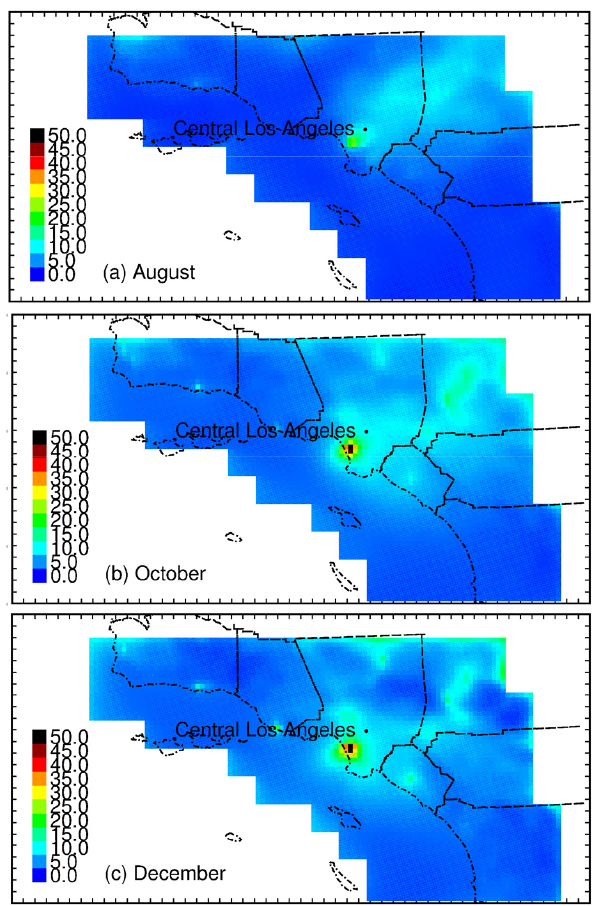
Figure 20. Seasonal variation of nucleated particle concentrations in southern California. Units are kcountscm − 3